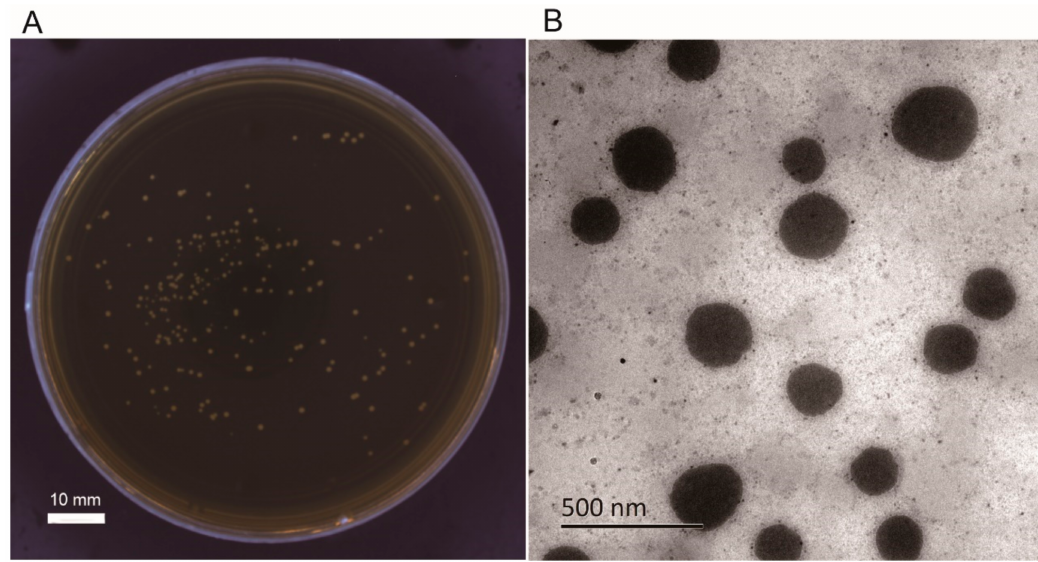
Figure 1. Colony counting medium and phytoglycogen nanoparticles used in this study. ( A ) Colony counting medium. ( B ) Phytoglycogen